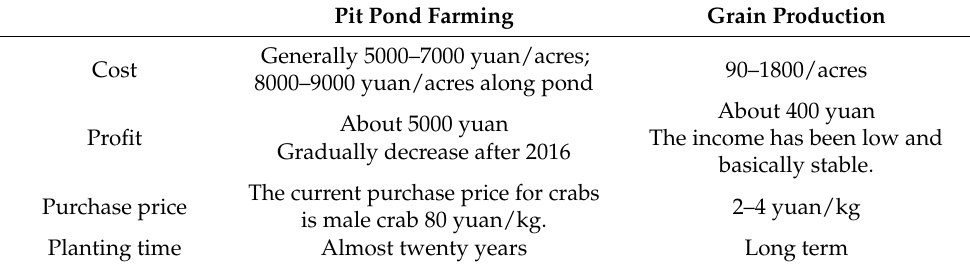
Table 7. Comparison of data related to pit pond farming and grain